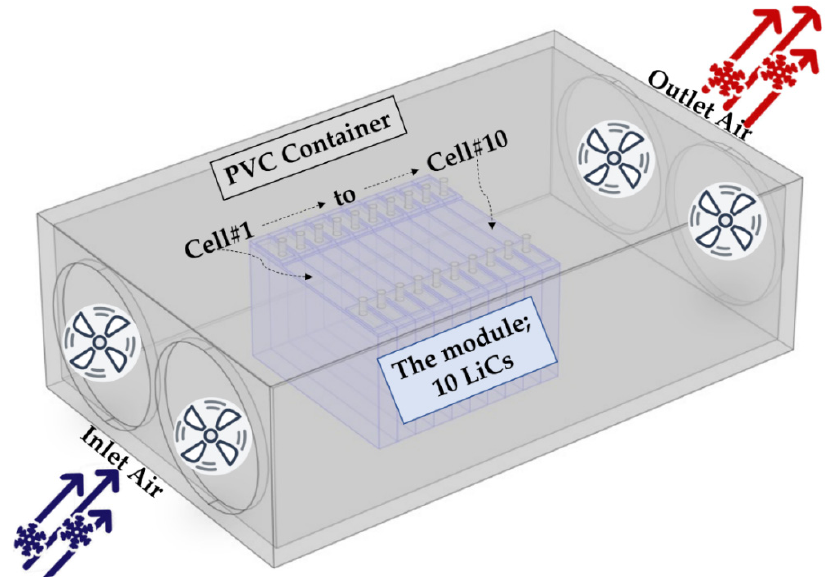
Figure 2. Schematic of the LiC module and the ACTMS in the CFD software.